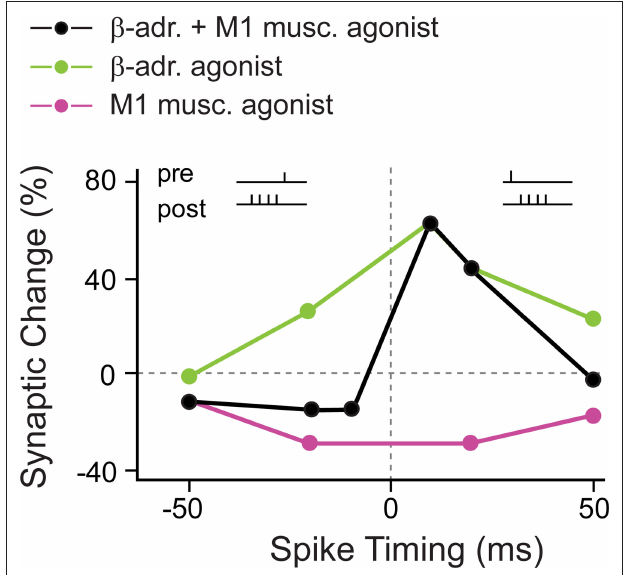
Figure 4 | Coapplication of β -adrenergic and M1 muscarinic agonists is required for “standard” bidirectional STDP in visual cortex. In the presence of a β -adrenergic agonist alone, close positive as well as negative pre–post timings induced t-LTP (green circles). When a M1 muscarinic agonist was present, close positive as well as negative pre–post timings induced t-LTD (red circles). Only the combined application of β -adrenergic and M1 muscarinic agonists resulted in the “standard” STDP window with close pre–post timings leading to t-LTP, and post–pre timings leading to t-LTD (black circles). (Modified from: Seol et al.,